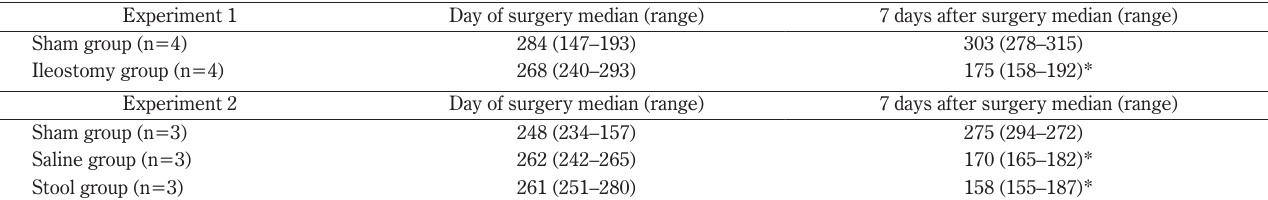
Table 1 Body weight (g) changes in sham and ileostomy-operated rats